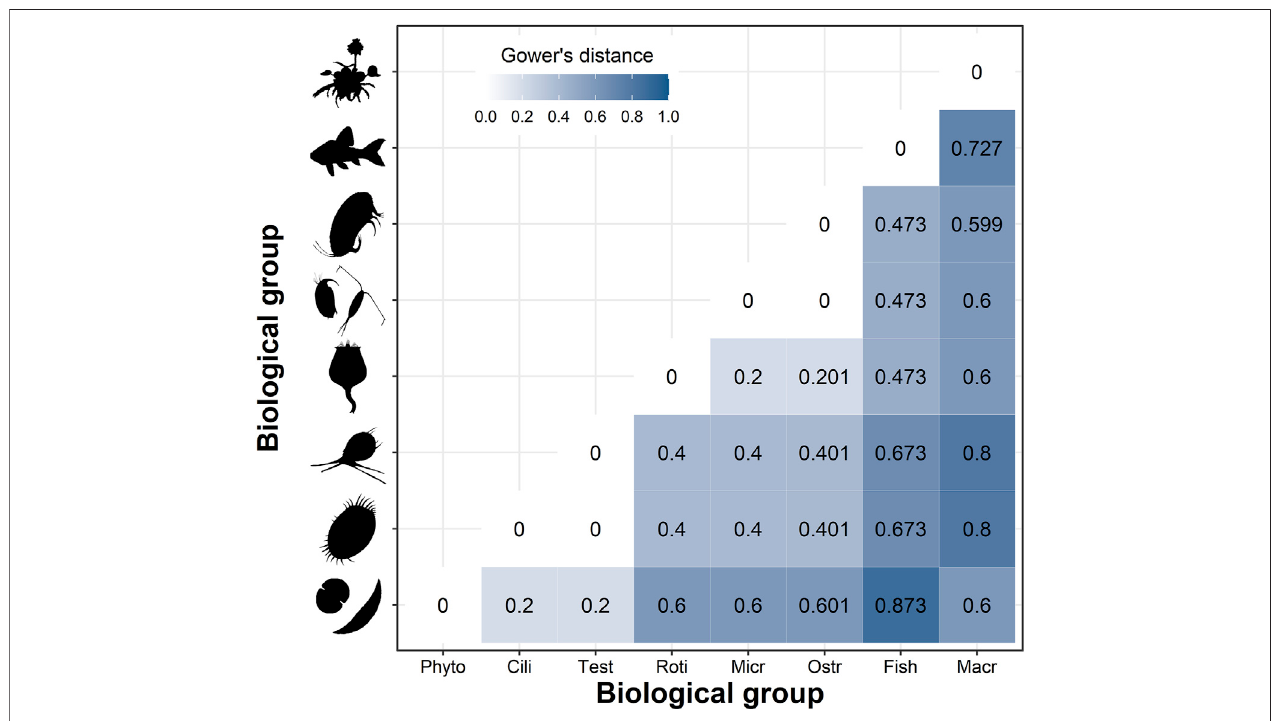
FIGURE 5 | Cross-taxon functional dissimilarities among all eight biological groups based on Gower´s index. Group codes: phytoplankton (Phyt), ciliates (Cili), testate amoebae (Test), rotifers (Roti), microcrustaceans (Micr), ostracods (Ostr), macrophytes (Macr).